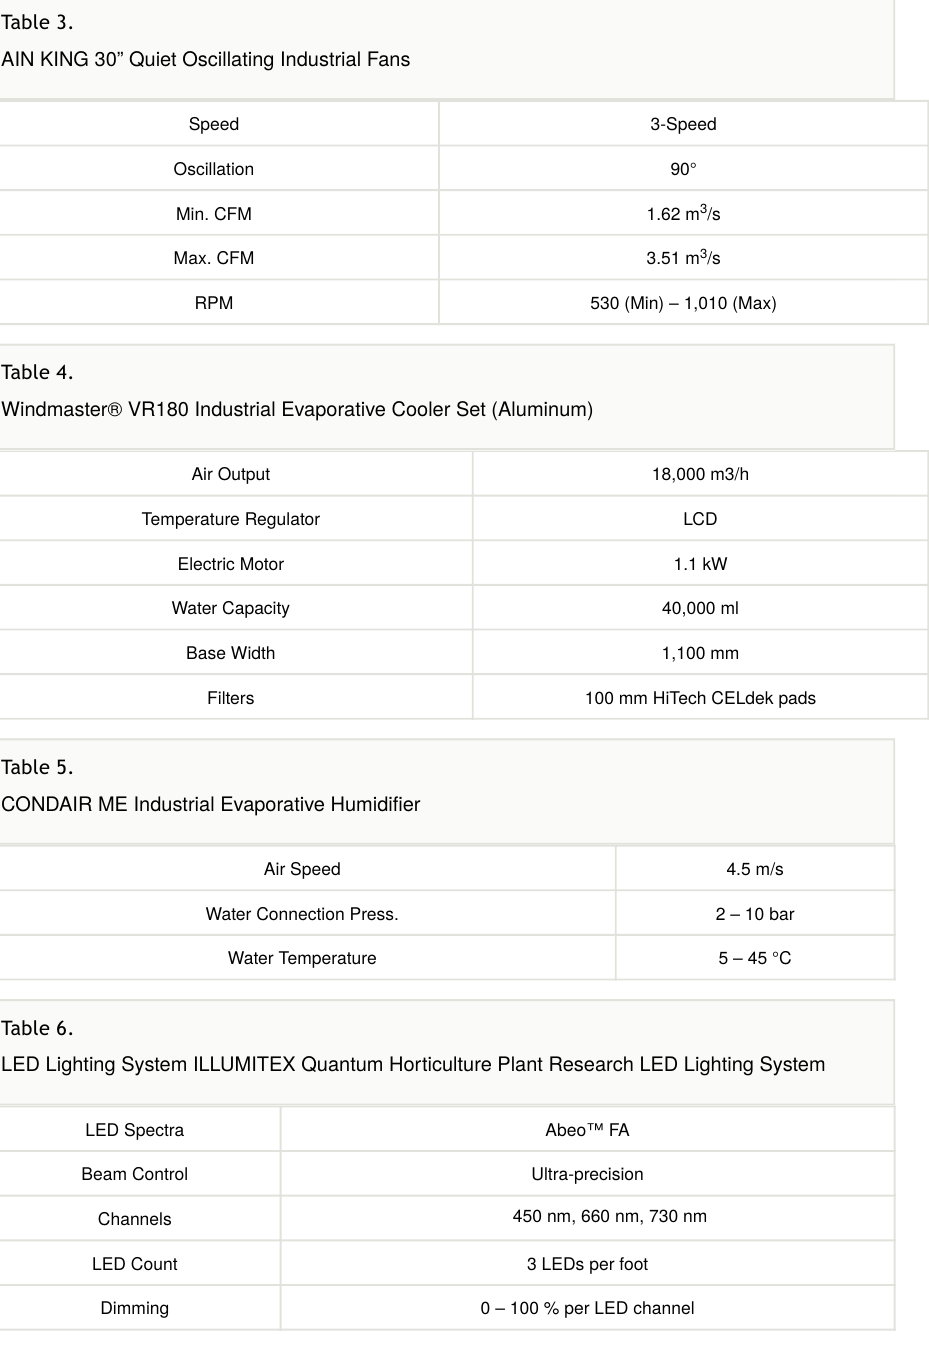
Vertical-Horizontal Regulated Soilless Farming via Advanced Hydroponics